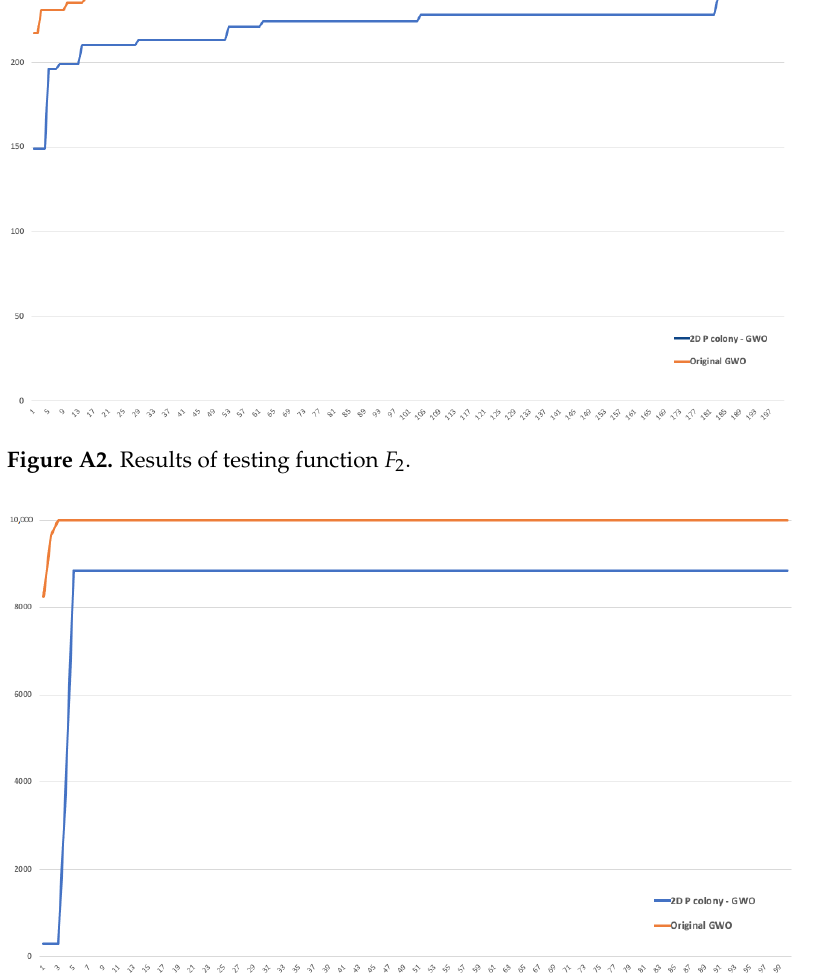
Figure A3. Results of testing function F 3